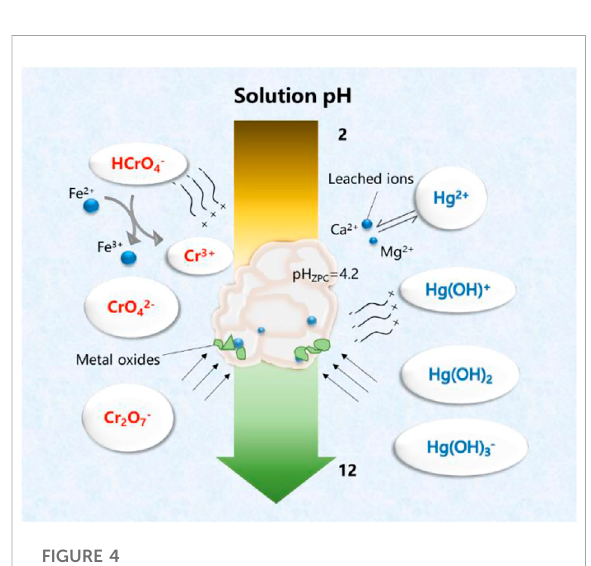
FIGURE 4 Conceptual representation of interactions between HCSS with mercury and chromium species in different solution